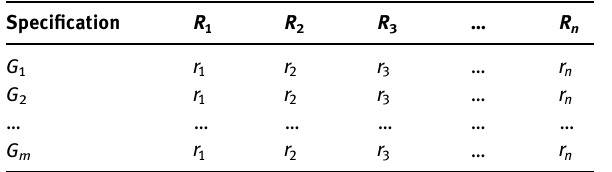
Table 2: Matrix of allocation of risk R i factors for speci fi c surveying tasks G i . Source: own study Speci fi